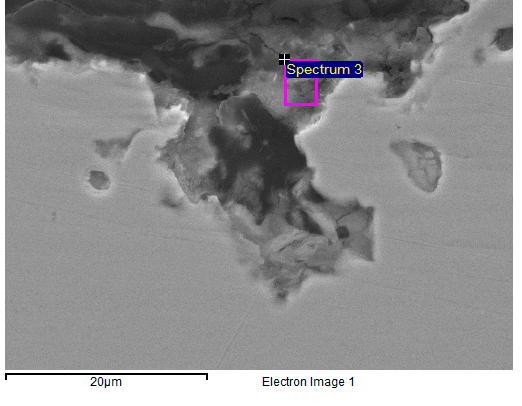
Figure 8. Surface image and elemental composition for the sample (test speed 500 rpm) obtained with CEM.